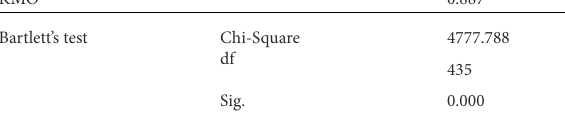
TABLE 9 SEM indexes and